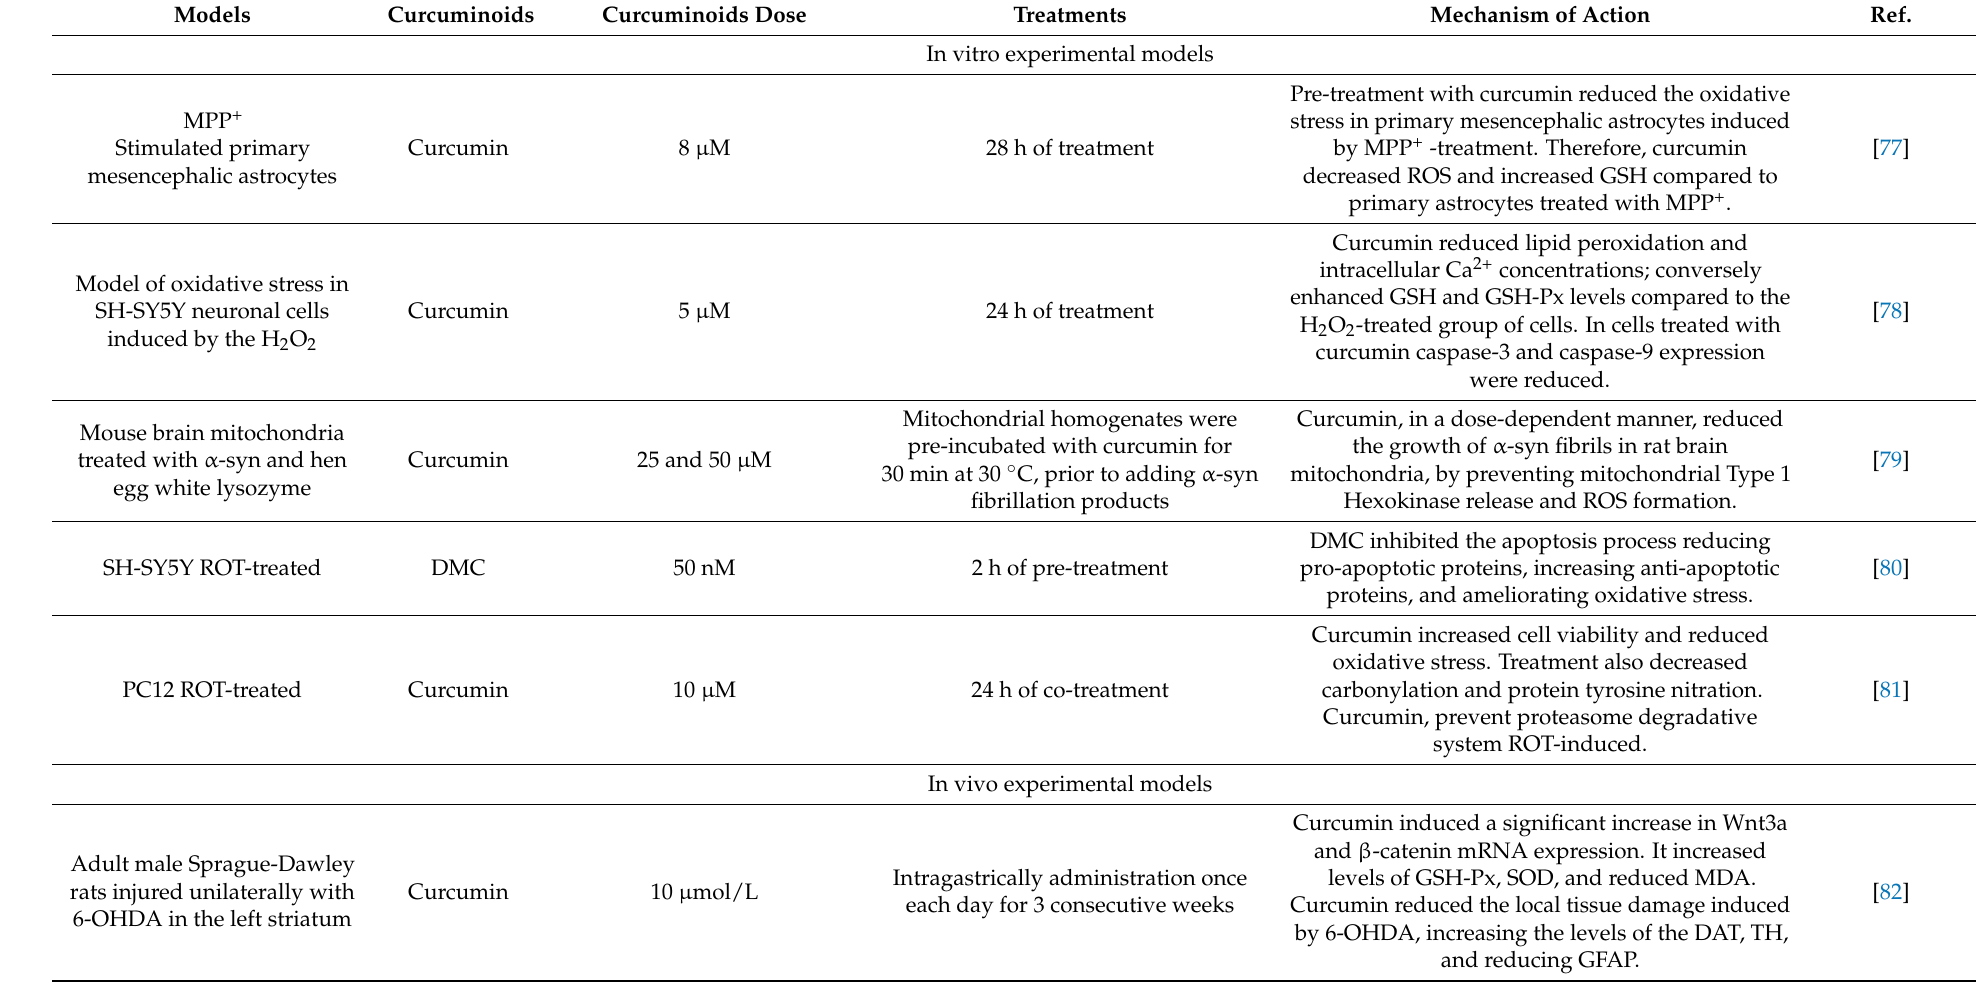
Table 1. Antioxidant effects of Curcuminoids in